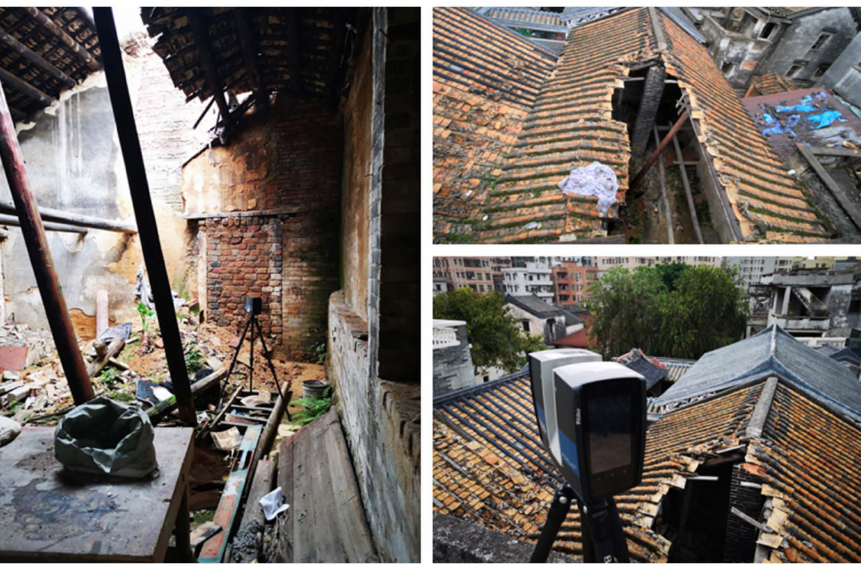
Figure 3. Faro S350 scanner. The Faro scanner is suitable for different kinds of sites, especially for architectural heritage